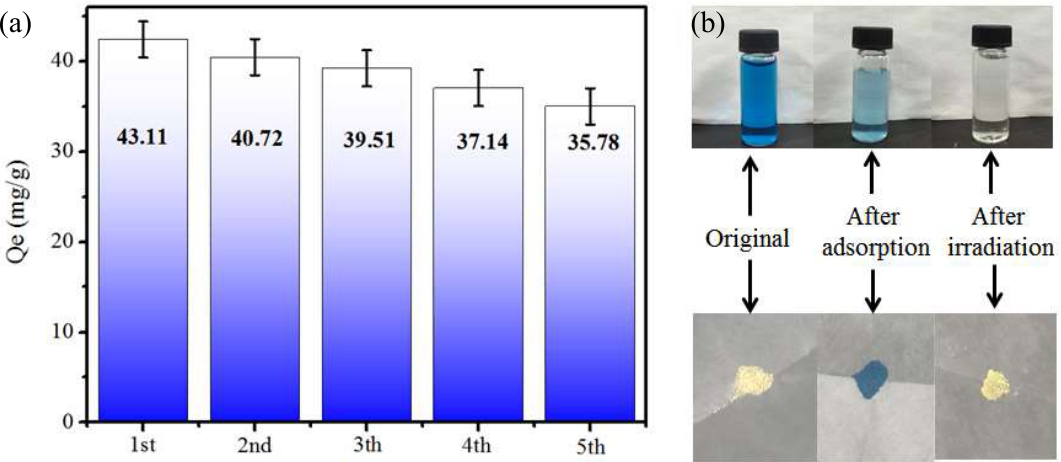
Figure 13. ( a ) cycling runs for the adsorption capacity of MB over B2-CN; ( b ) the MB solution and sample color in the original, after adsorption, and after irradiation stages.